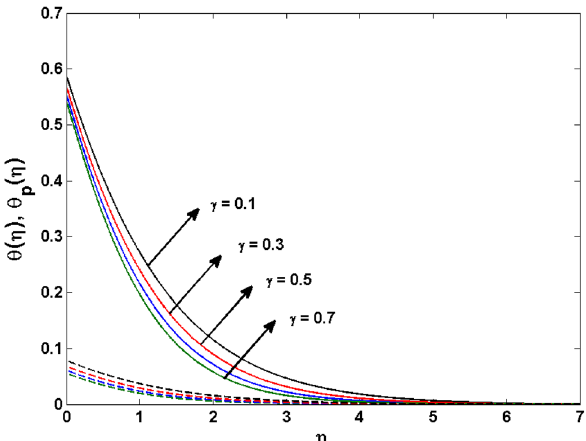
Figure 11. θ(η) and θ p (η) for various estimates of γ .